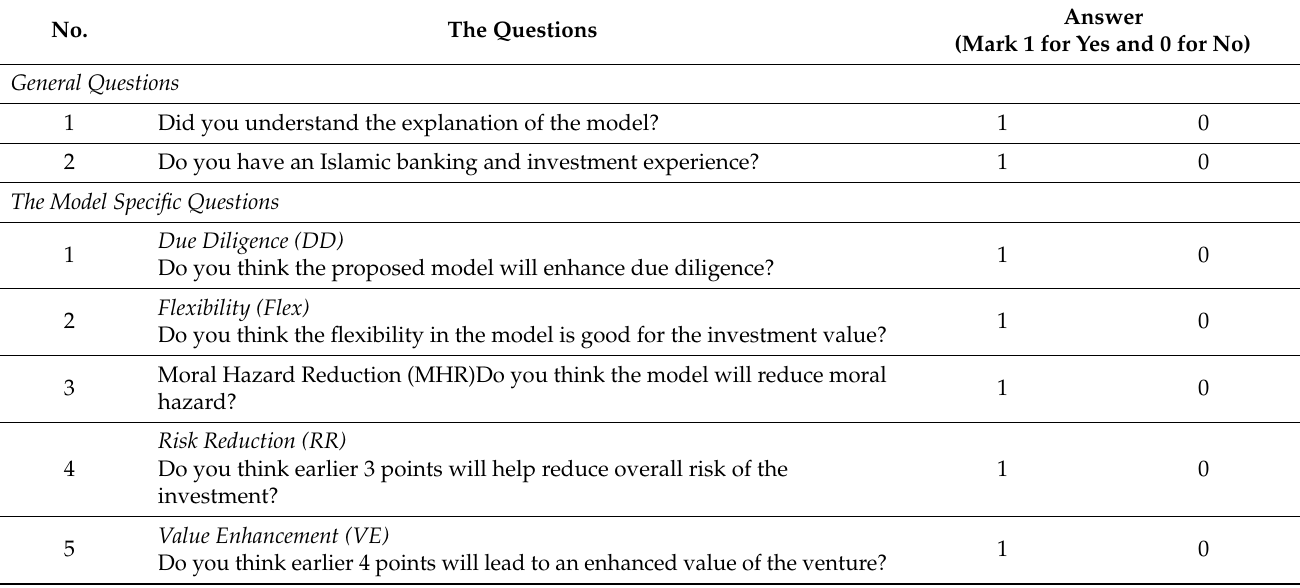
Table 1. The survey